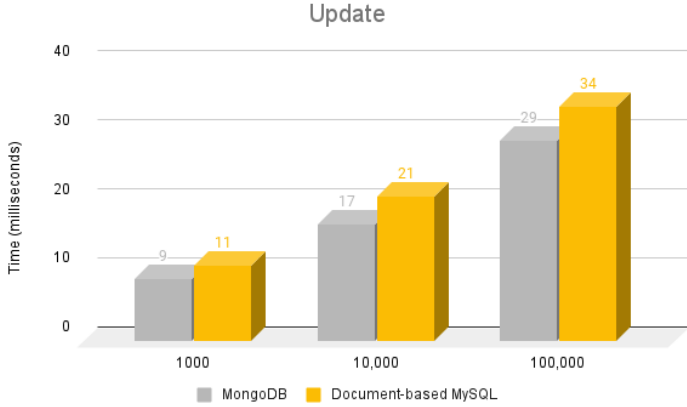
Figure 4. Execution times for the update operation.